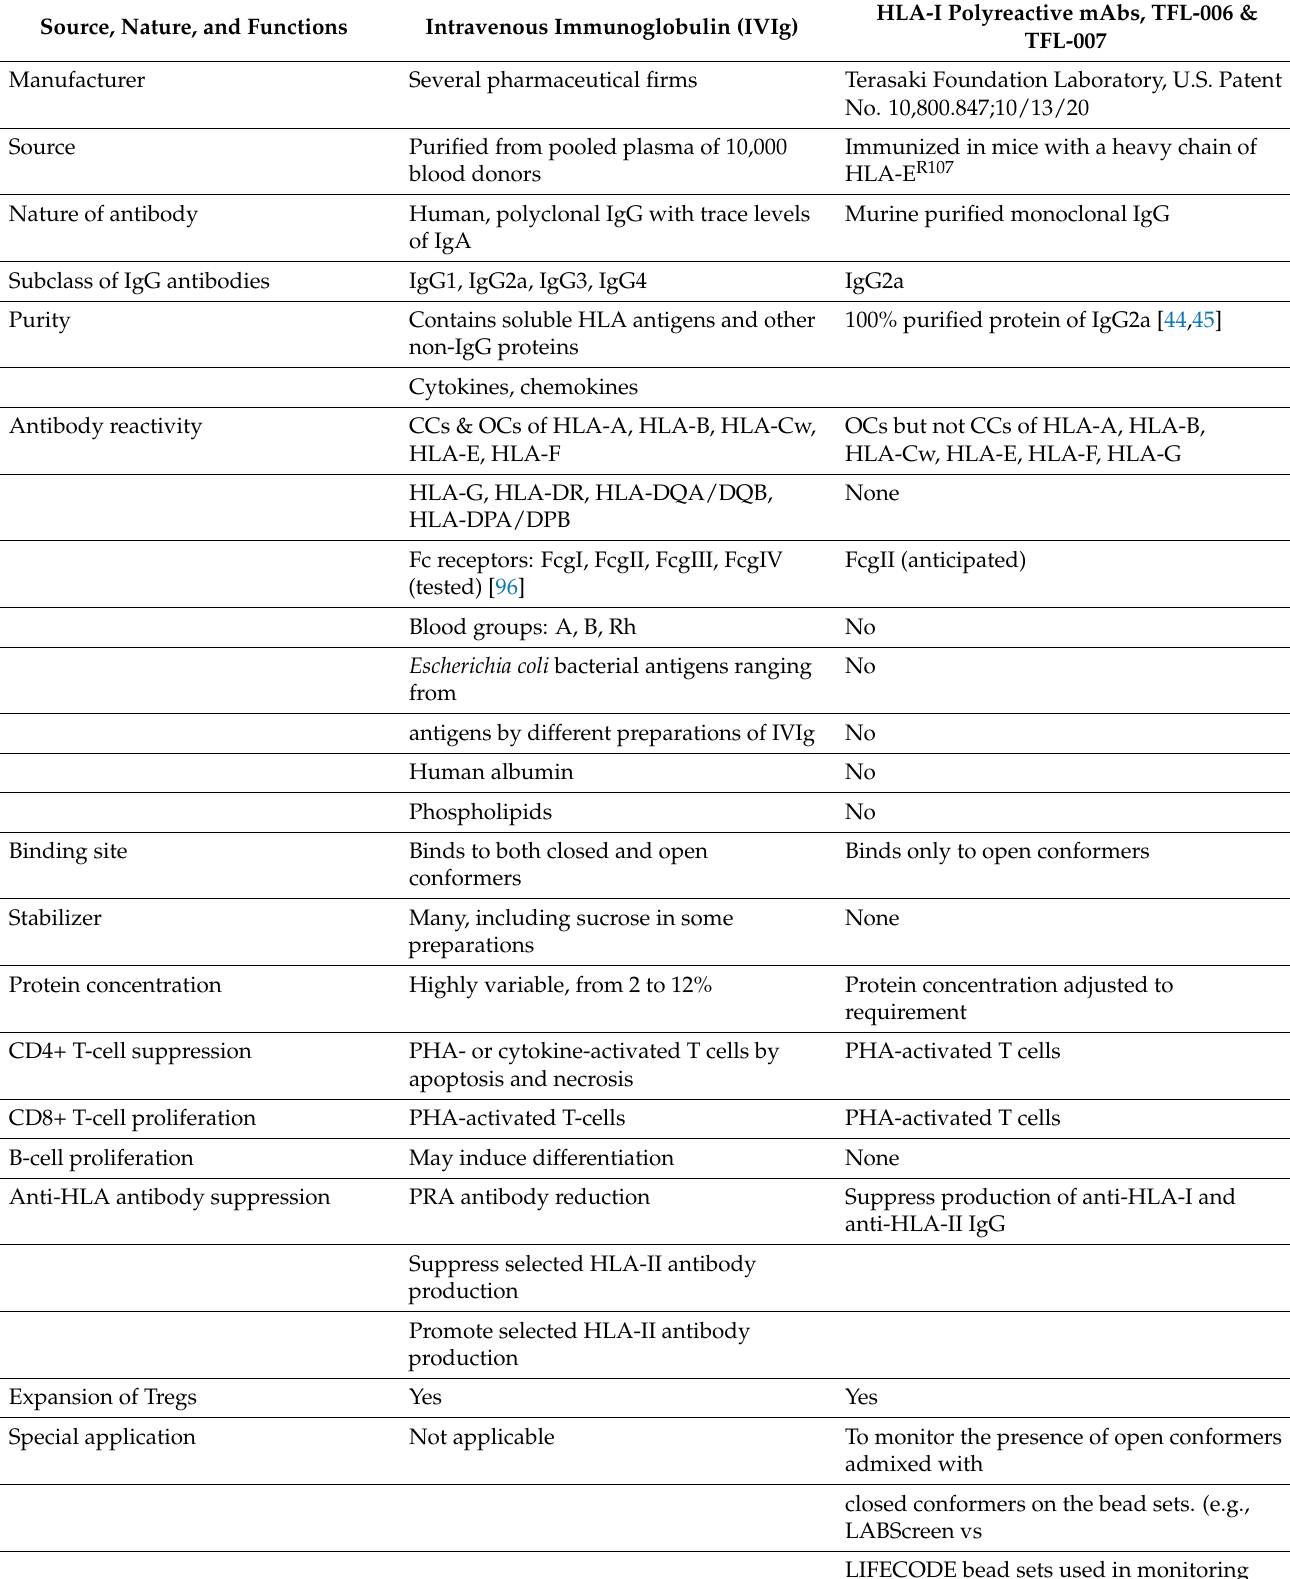
Table 7. Comparison of natural and functional characteristics of IVIg and HLA-I polyreactive